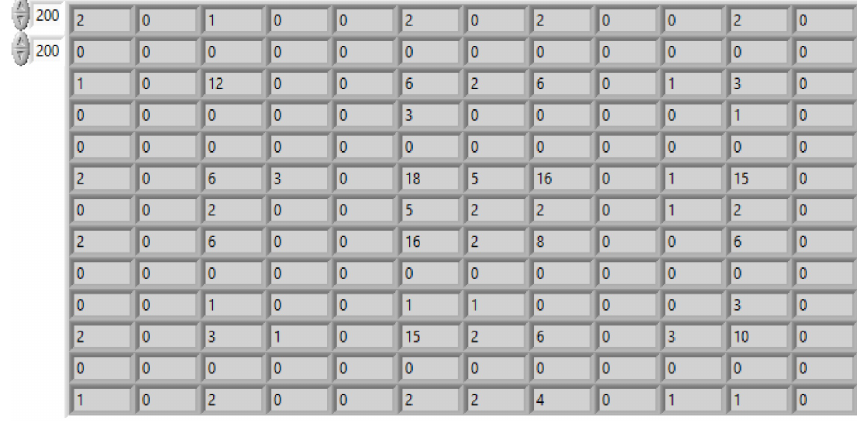
Figure 15. Part of the GLCM matrix for image in Figure